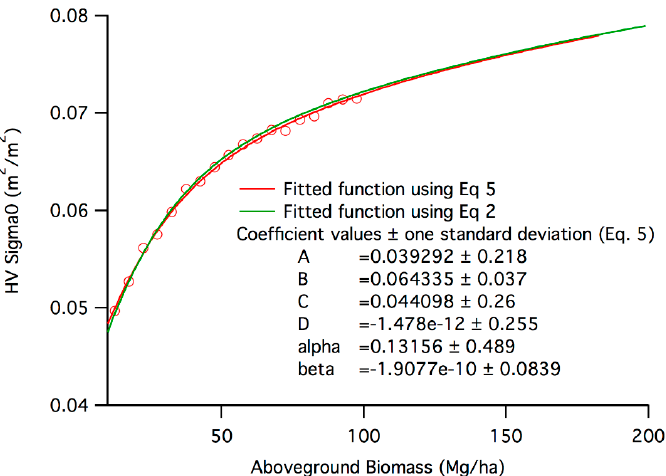
Figure 7. Average sigma-0 values (m 2 ·m − 2 ) for temperate conifer forests within 5 Mg·ha − 1 biomass bins. Red line is the fitted function using Equation (5) (with surface-volume scattering term) while green line is the fitted function using Equation (2) (with only canopy volume scattering term). The coefficients shown are those fitted for Equation (5) with ±1 standard deviation.